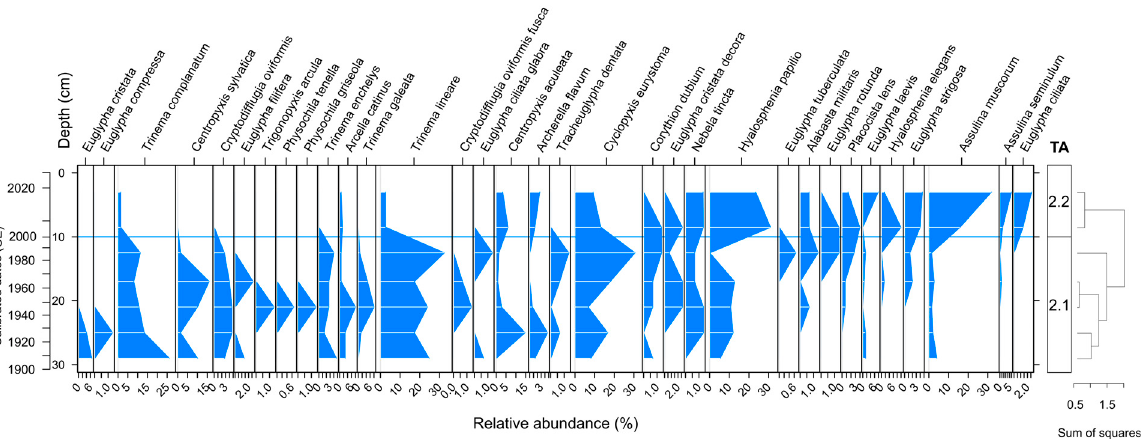
Figure 7. The species composition of testate amoeba assemblages in the peat deposits of floating mat in the Gorenki mire. Zones TA2.1–TA2.2 with a homogeneous composition were distinguished based on the constrained incremental sum of squares. The participation of pollen taxa is presented as a percentage of the pollen sum, and spore taxa as a percentage of the pollen and spore sum. CE—Common Era.